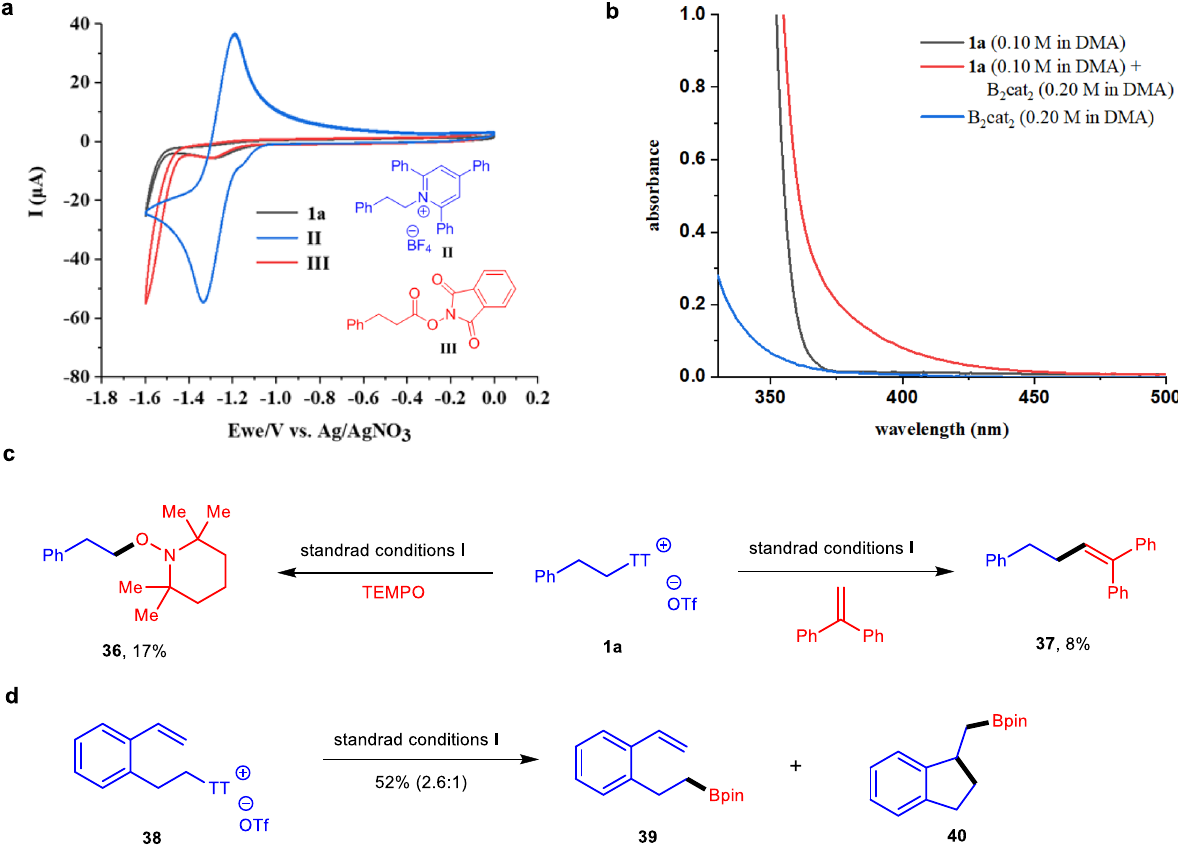
Fig. 6 Mechanistic studies. a Cyclic voltammograms (CV) of thianthrenium salt 1a , Katritzky salt II and NHPI ester III . b UV/visible absorption spectra of DMA solutions of 1a (0.1 M), B 2 Cat 2 (0.2 M), and a mixture of 1a (0.1 M) and B 2 cat 2 (0.2 M) in DMA. c Radical trapping experiments of thianthrenium salt